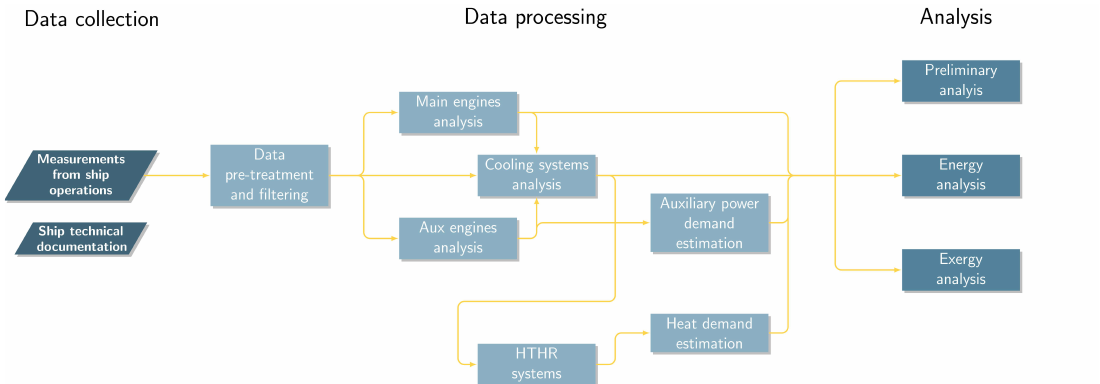
Figure 3. Overview of the method, including the inputs coming from the data collection, the data processing, and the outputs of the energy and exergy